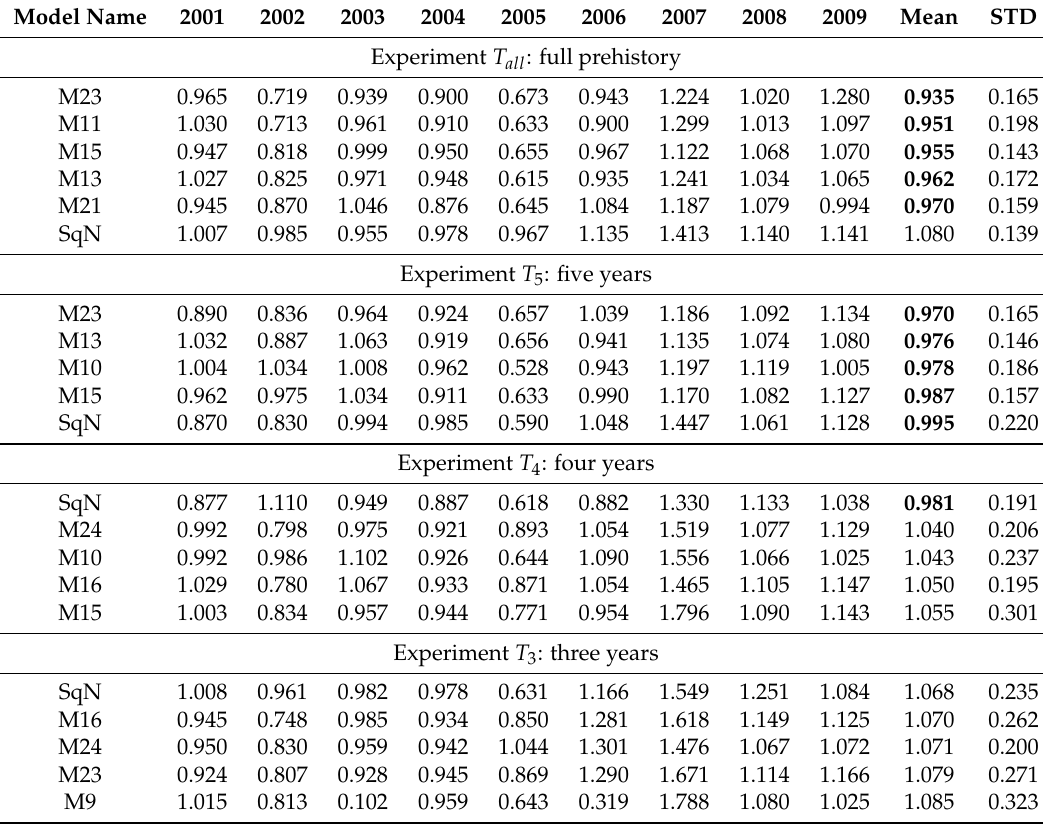
Table 3. Top Five models for the temporal experiments. Average MAE < 1 are